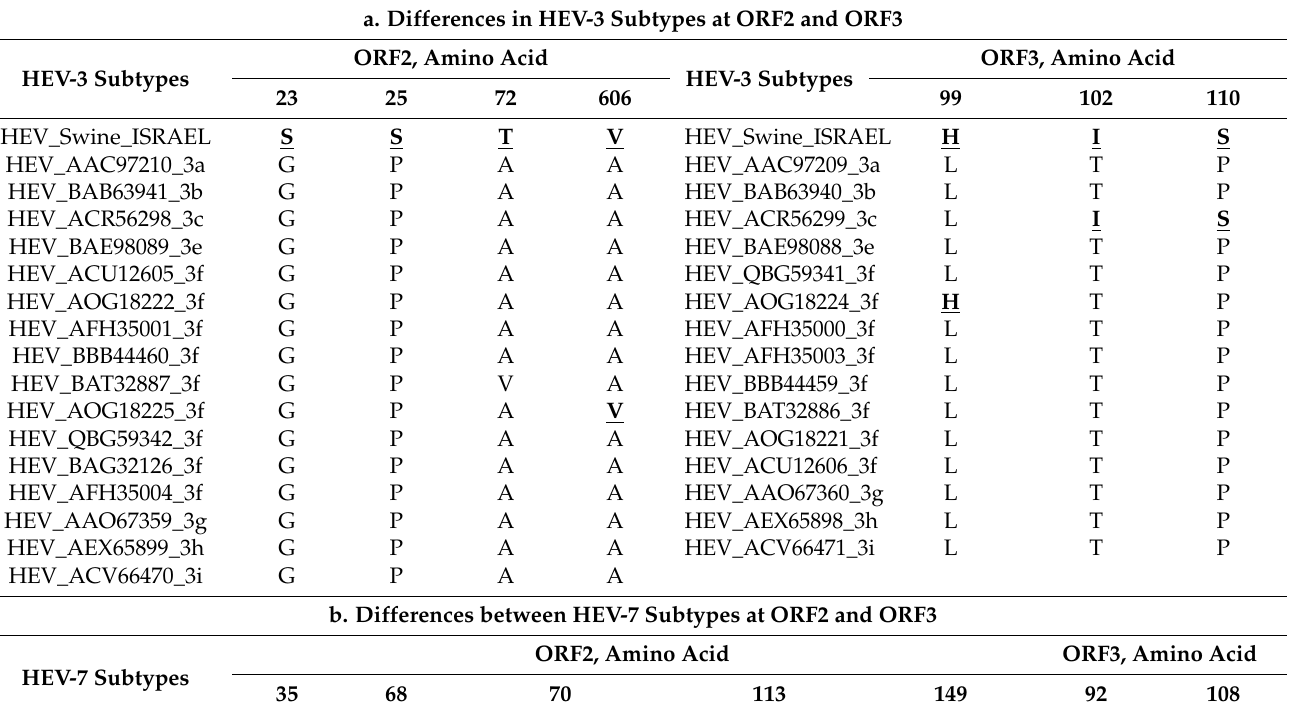
Table 2. Differences in deduced amino acids between local and published sequences. a. Differences in HEV-3 Subtypes at ORF2 and